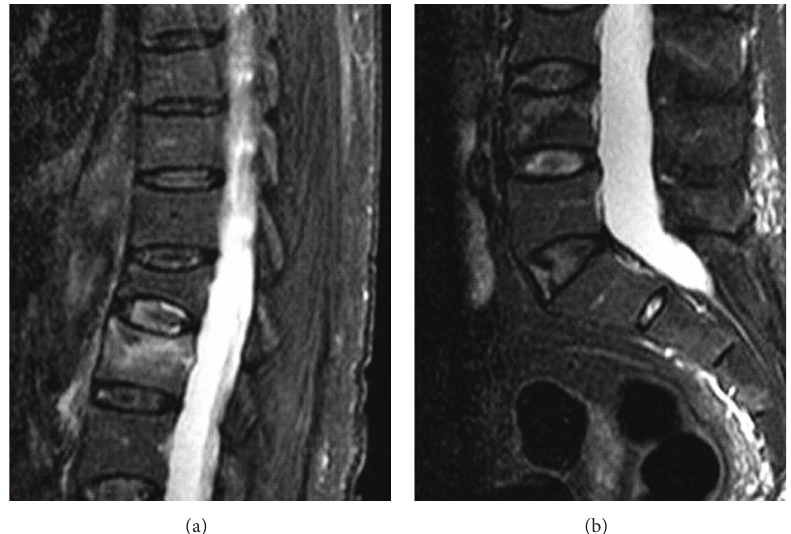
F 1: Sagittal STIR MR dorsal (a) and lumbar (b) image. MR image shows deformity of T12 vertebral body, which is chronic; there is no bone marrow edema. e recent fractures of L1 and L4 are much less deformed but have high signal from bone marrow